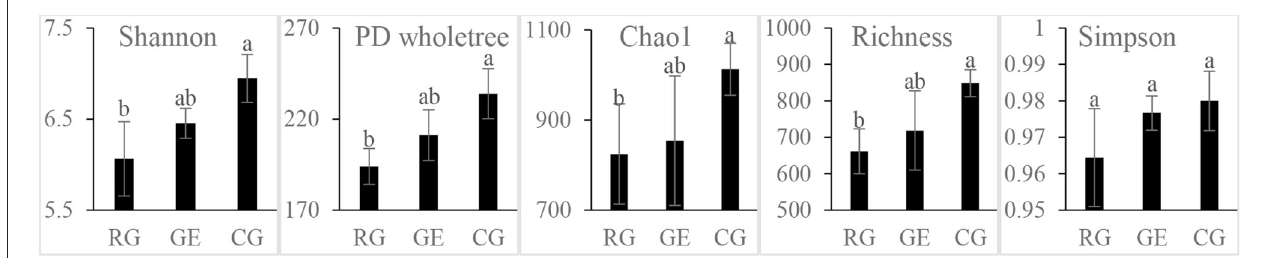
FIGURE 2 | Soil fungal diversity among the grazing regimes. GE, grazing exclusion; RG, rotational grazing; and CG, continuous grazing. Different lowercase letters indicate significant differences between grazing regimes ( p < 0.05).